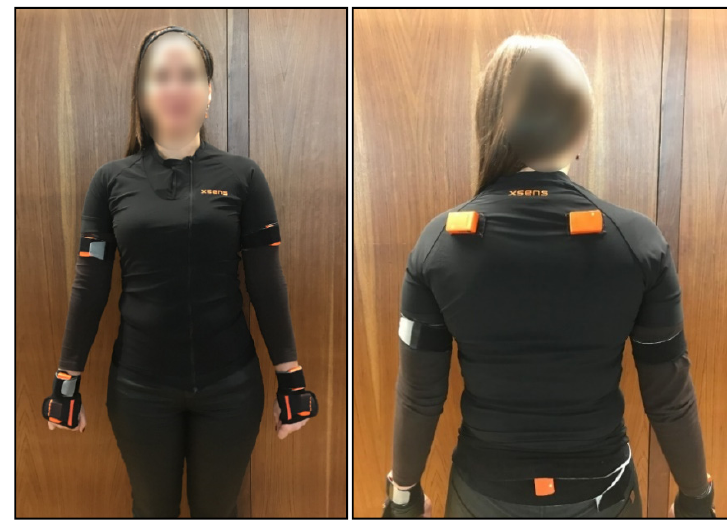
Figure 5. Participant with the 11 inertial sensors attached.